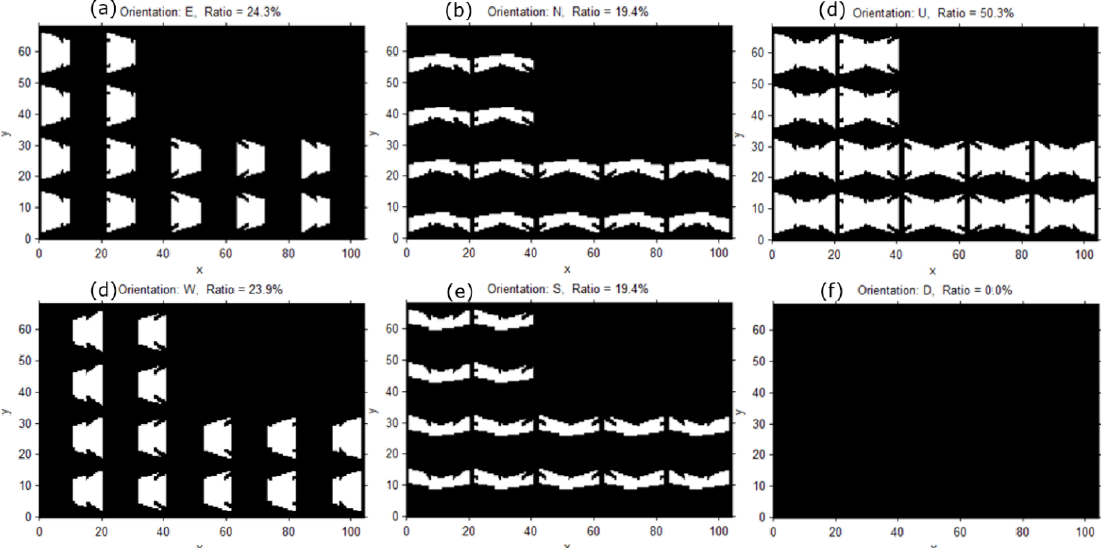
Figure 9. Surveillance coverage index with a threshold of 1 px/cm according to the orientation when objects are at an elevation of 0.5 m; ( a ) the index with the eastward orientation; ( b ) the index with the northward orientation; ( c ) the index with the upward orientation; ( d ) the index with the westward orientation; ( e ) the index with the southward orientation; ( f ) the index with the downward